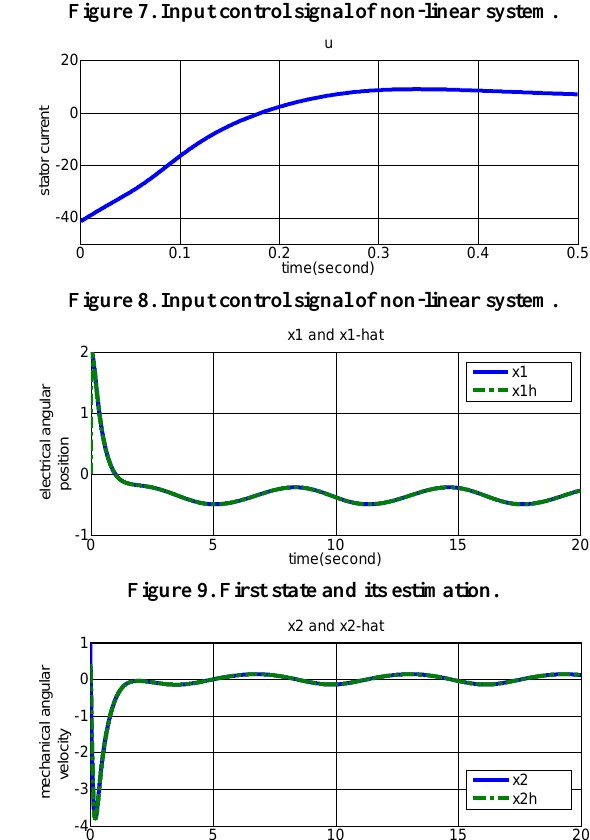
Figure 7. Input control signal of non-linear system.